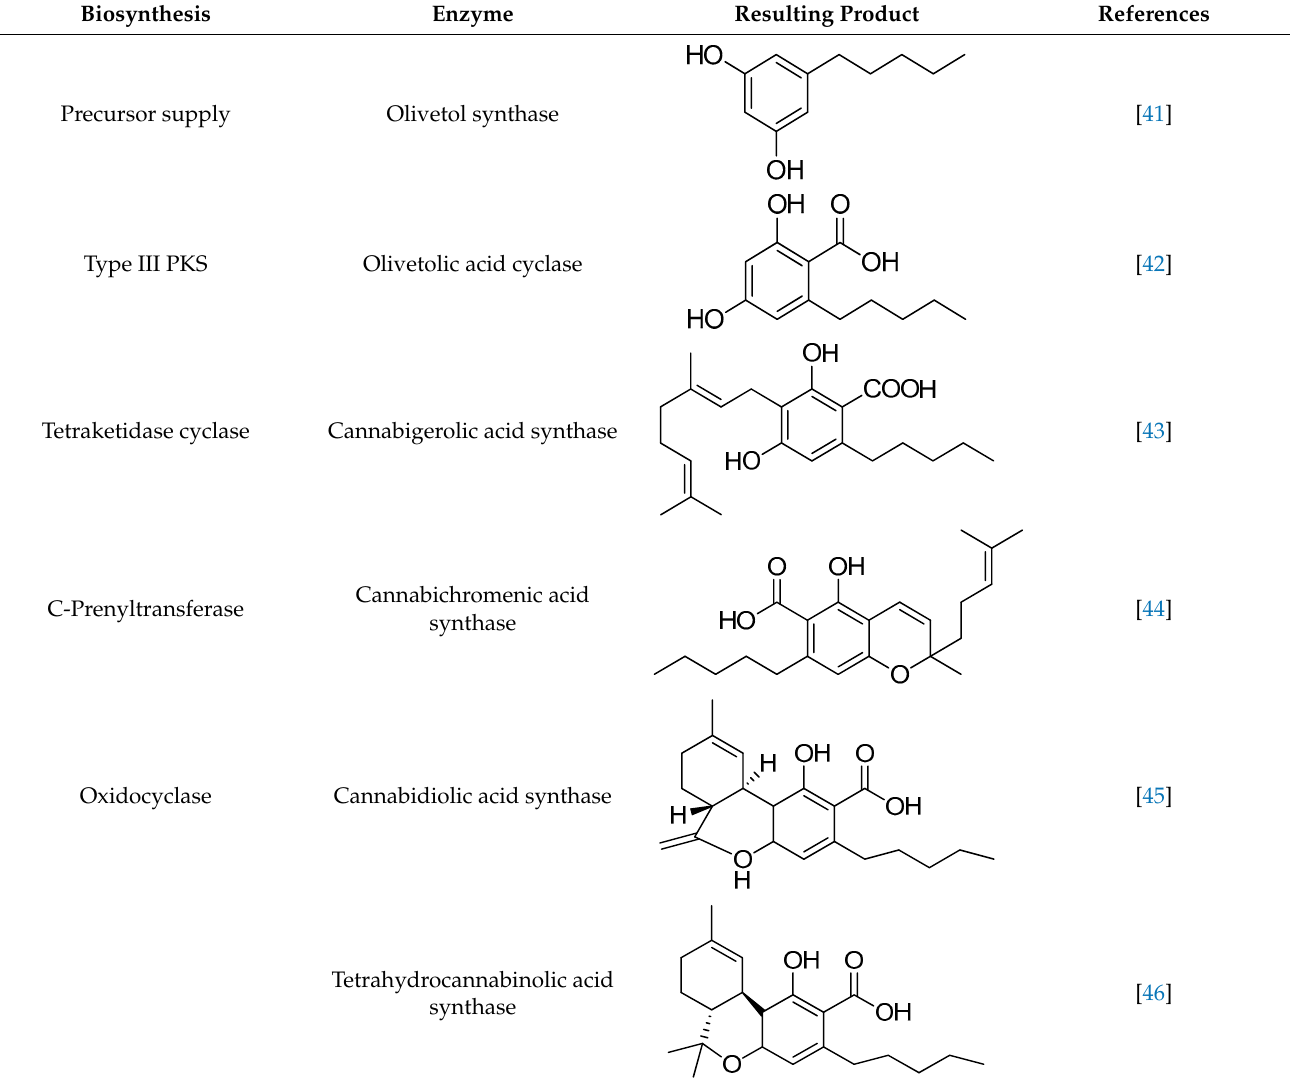
Table 1. The Enzymatic Reaction in the biosynthesis of phytocannabinoids.